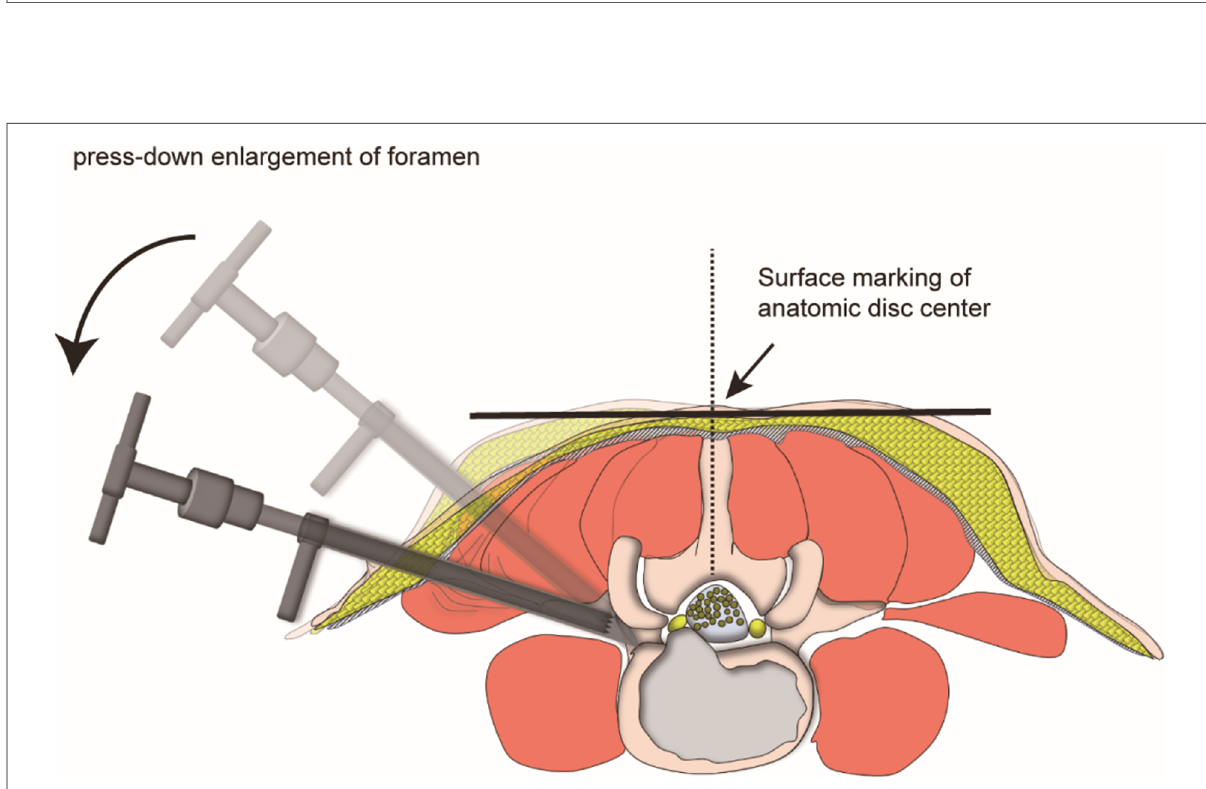
FIGURE 3 Schematic diagram of “ press-down enlargement of foramen ” in FITS. The 8.8-mm protective cannula was docked at the facet joint and pressed down further to make the angle of cannula to horizontal plane smaller, and a 7.5-mm trephine was introduced to cut the ventral bone of articular process for the enlargement of intervertebral foramen, which made the working channel easily inserted into the spinal canal even if the puncaire angle was 85° to the horizontal